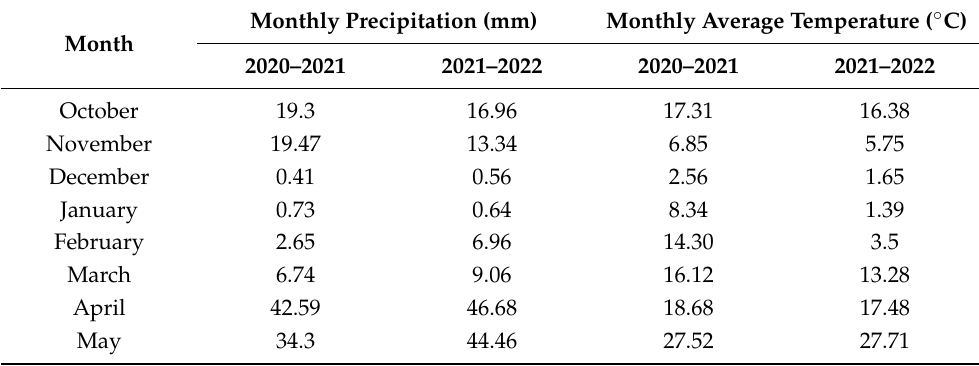
Table 2. Chemical and physical properties of soil. Parameters